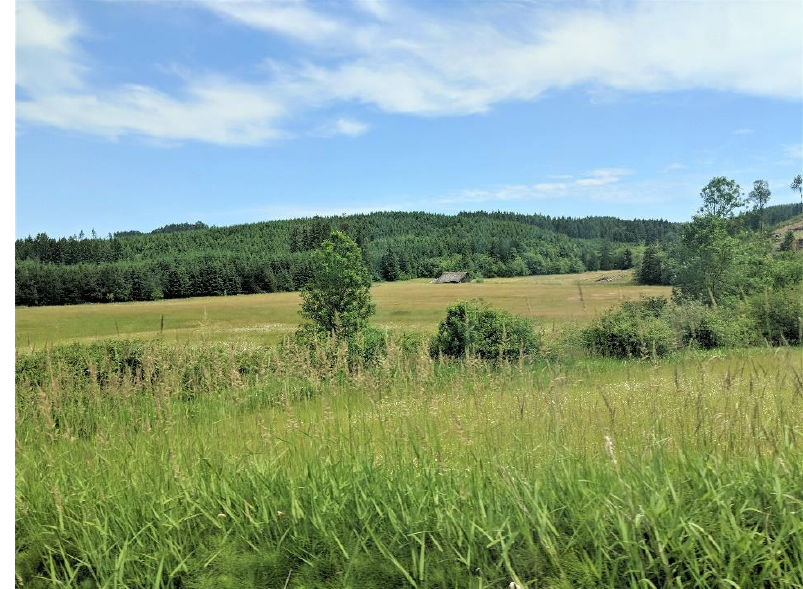
Figure 3. A rural landscape in Lewis County in southern Washington, USA.